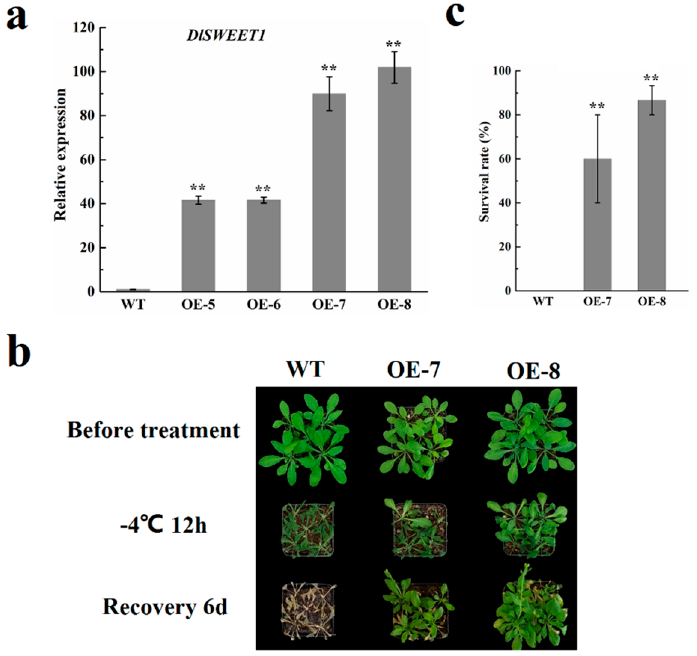
Figure 8. Overexpression of DlSWEET1 in Arabidopsis improved cold tolerance. ( a ) The relative expression levels of DlSWEET1 in WT and T3 transgenic Arabidopsis lines. AtACTIN2 was used as an internal control. ( b ) Phenotypes of DlSWEET1 transgenic Arabidopsis lines (OE-7 and OE-8) and WT under low-temperature stress and recovery. ( c ) Survival rates of the transgenic lines and WT plants after freezing. Values presented as mean ± standard error (SE) ( n = 3). Small star above the bars indicate significant differences (** p ≤ 0.01).